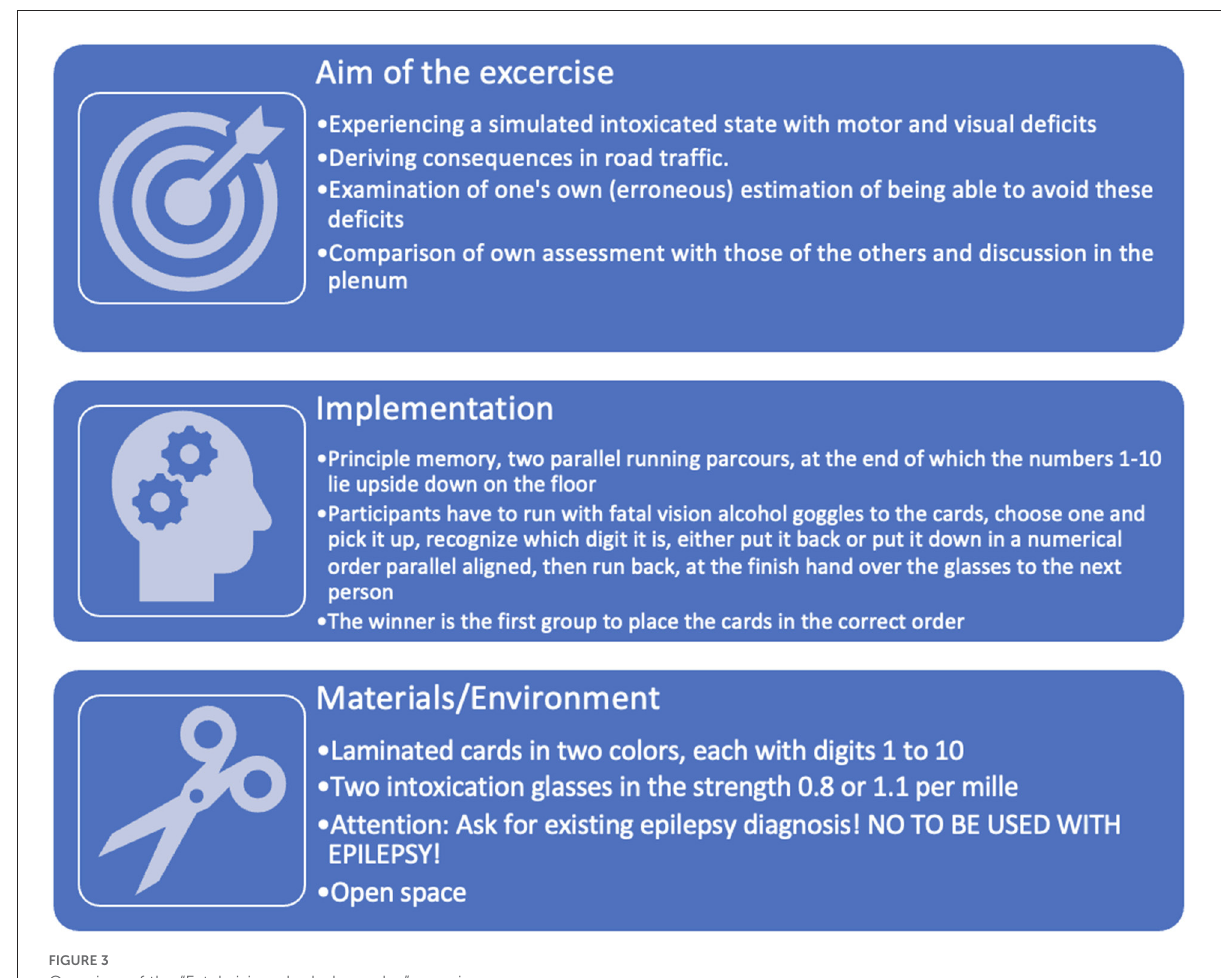
FIGURE3 Overview of the “Fatal vision alcohol goggles”